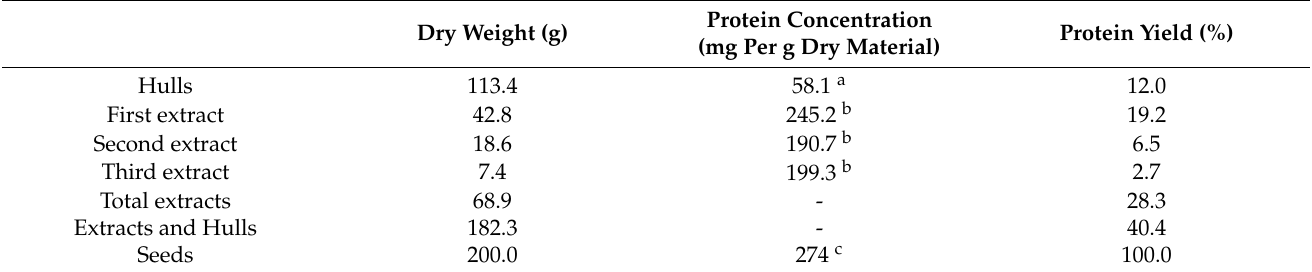
Table 2. Protein extraction from wet tomato seeds using consecutive high shear mixing